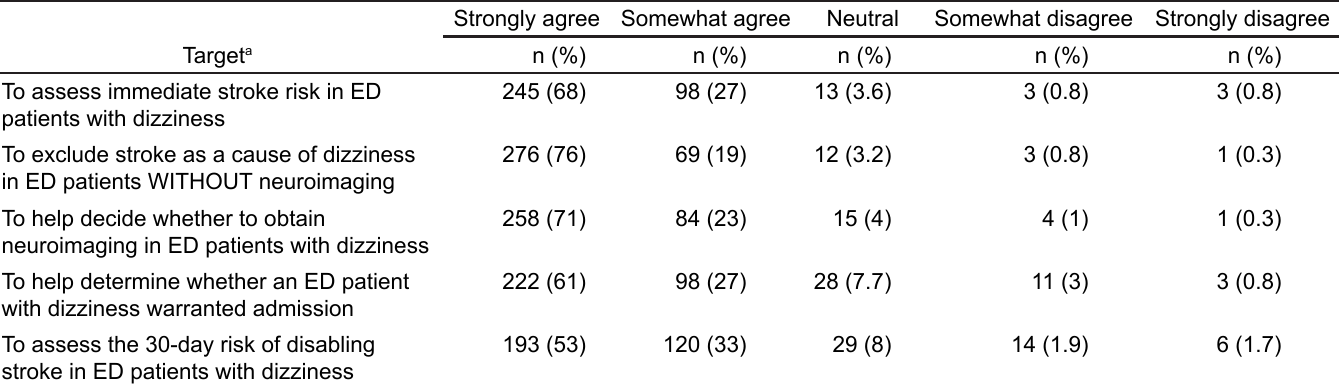
Table 3. Potential targets for a clinical prediction rule for